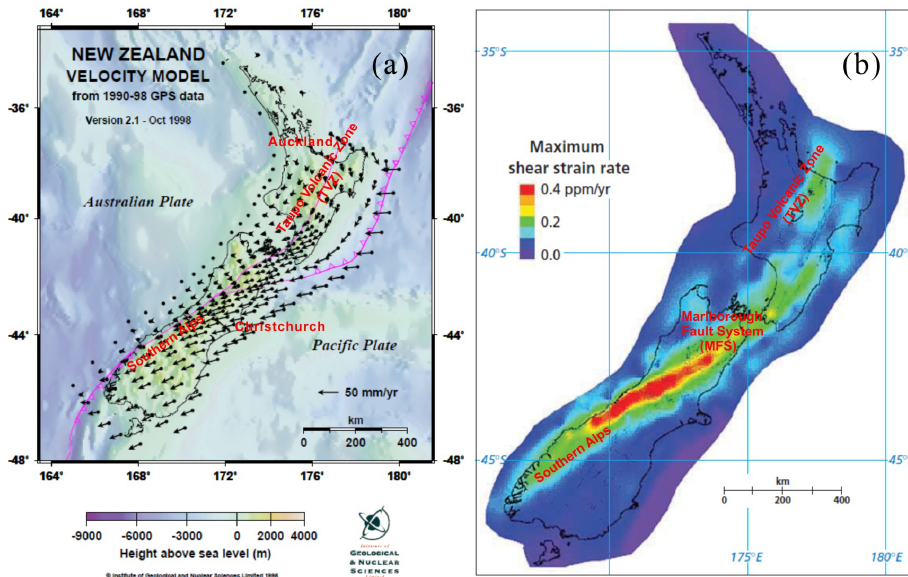
Fig. 6. (a) Velocity model of New Zealand relative to the Australian Plate. It shows how far the point moves relative to the Australian plate in 1 year. Points near Auckland move hardly at all. Points near Christchurch move southwest at about 40mm each year (from GNS Science). (b) Shear train map. Maximum shear strain map shows the rate at which shearing or sideways deformation is taking place. The red areas are those that are undergoing the most shear strain. The units on the scale bar are ppm/yr or parts per million per year (from GNS Science).